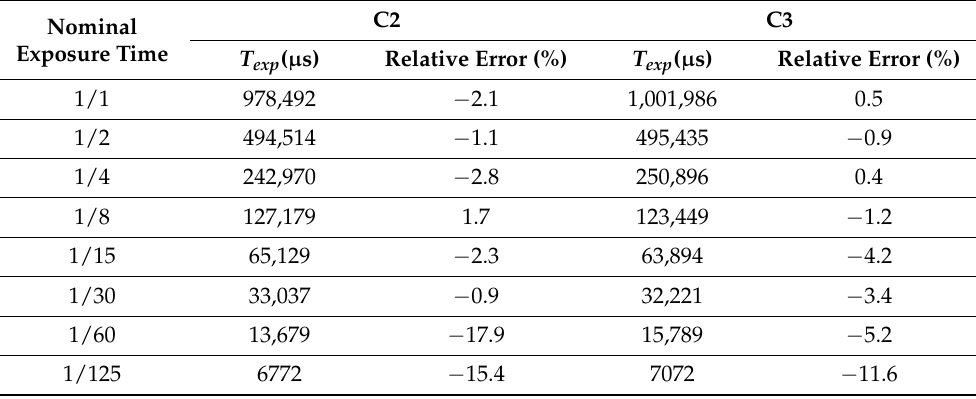
Table 3. Turntable measurement results for C2 and C3.